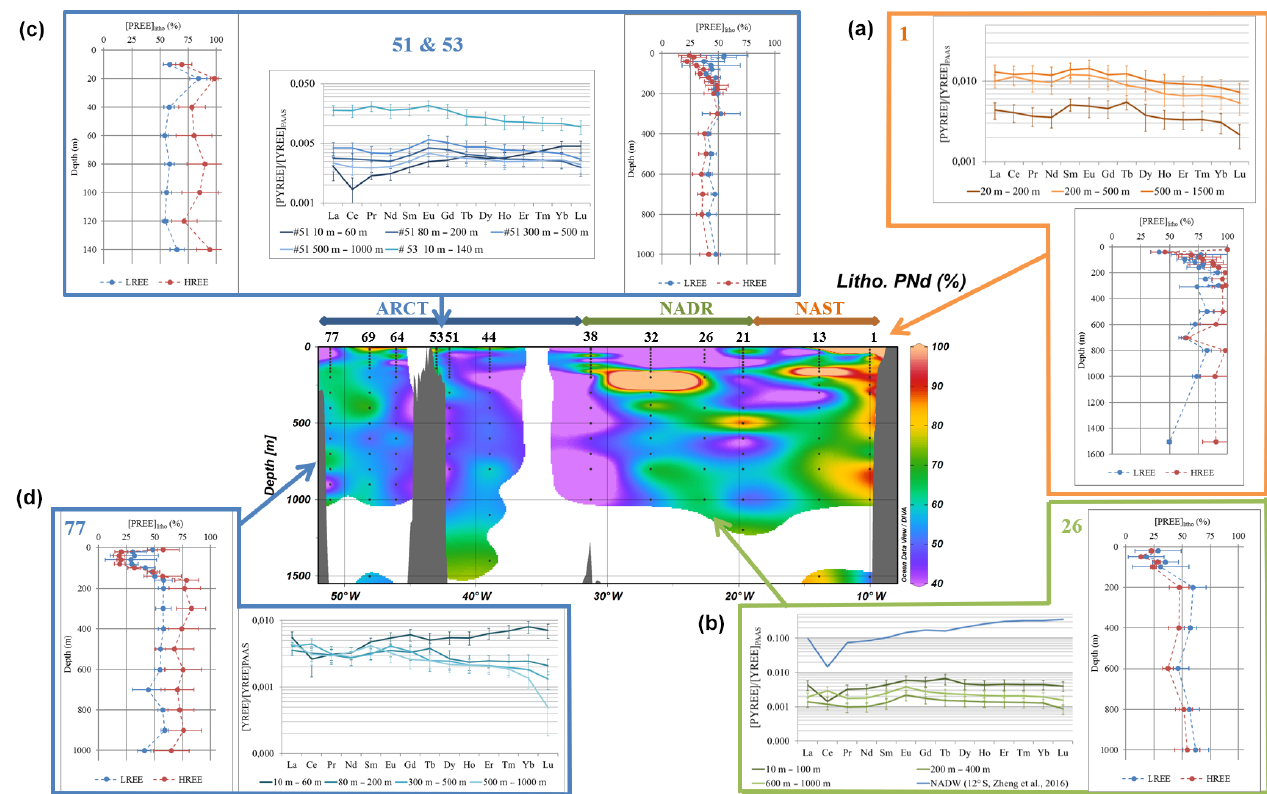
Figure 5. Center: fraction of lithogenic PNd along the GEOVIDE section (in %); side plots: vertical profiles of the lithogenic fraction of LREE (except Ce, blue lines) and HREE (red lines) and PAAS-normalized REE patterns of the total fraction at station nos. (a) 1, (b) 26, (c) 51, and 53 and (d) no. 77. Patterns are averaged by depth intervals displaying similar values. Error bars represent the standard deviation of the concentration series. A typical seawater pattern (NADW; 12 ◦ S, 2499m, Zheng et al., 2016) is represented along with patterns of station no. 26 with a blue